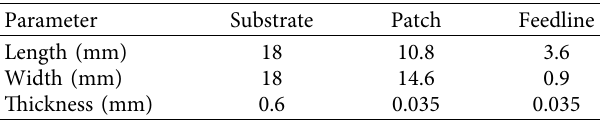
Figure 2: Proposed reference microstrip antenna model on the finite ground plane. Figure 1: Genetic algorithm flow chart for antenna optimization. Table 1: Summary of dimensions for the referenced antenna